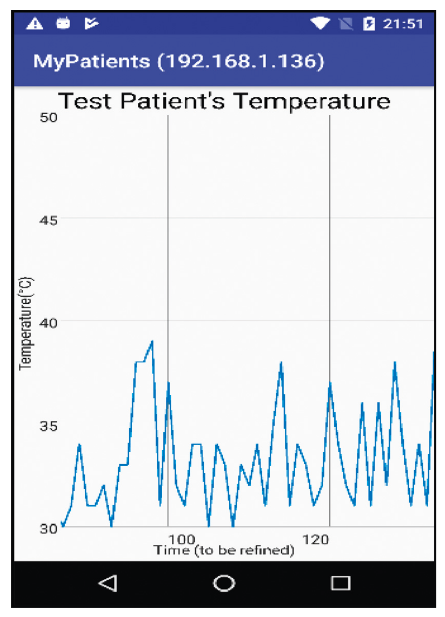
Figure 6: Temperature data on the physician’s